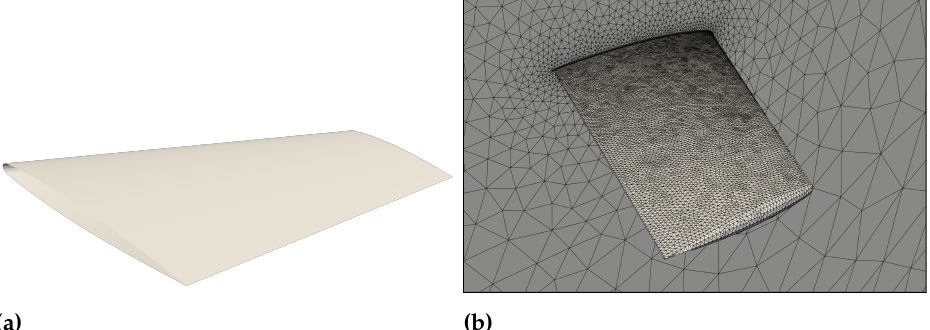
Figure 26. ( a ) ONERA wing configuration and ( b ) sample mesh.